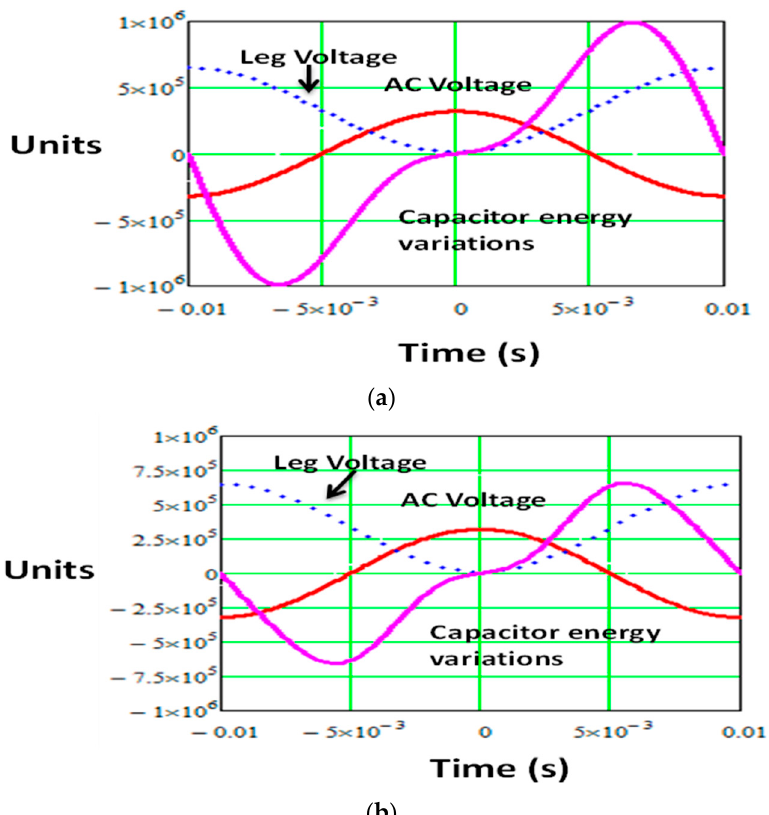
Figure 10. Results of ( a ) change in capacitor energy-direct modulation and ( b ) change in capacitor energy-proposed method.